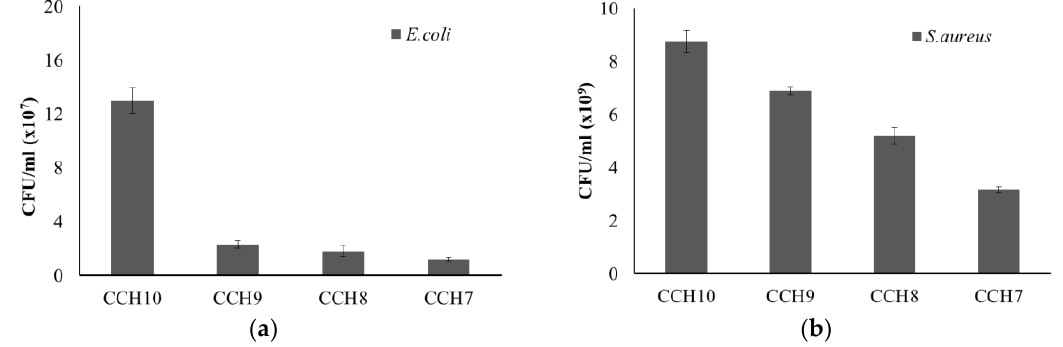
Figure 5. Antibacterial activity of the CCH films on the growth of E. coli ( a ) and S. aureus ( b ).